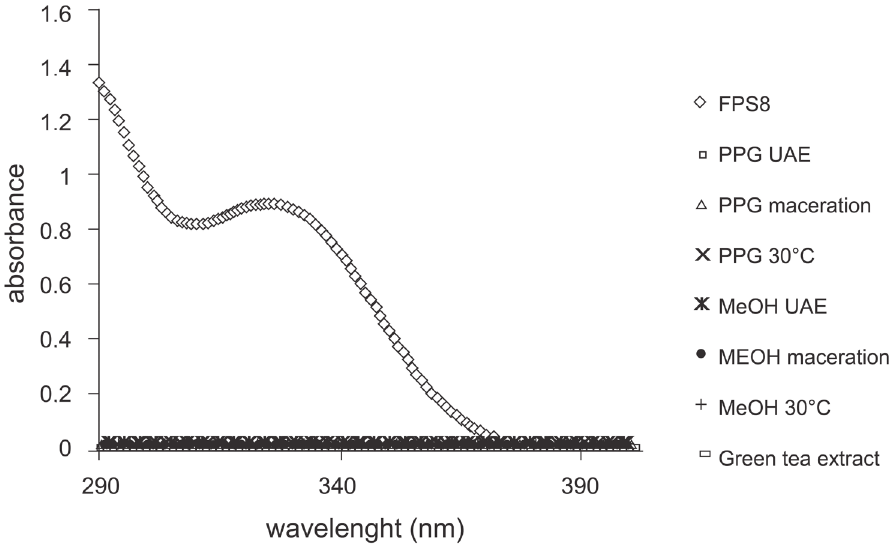
FIGURE 2 - UV absorption spectra of the topical emulsion formulations at 0.2 mg mL -1 . FPS8: standard formulation. PPG: propylene glycolyc extracts. MeOH: methanolic